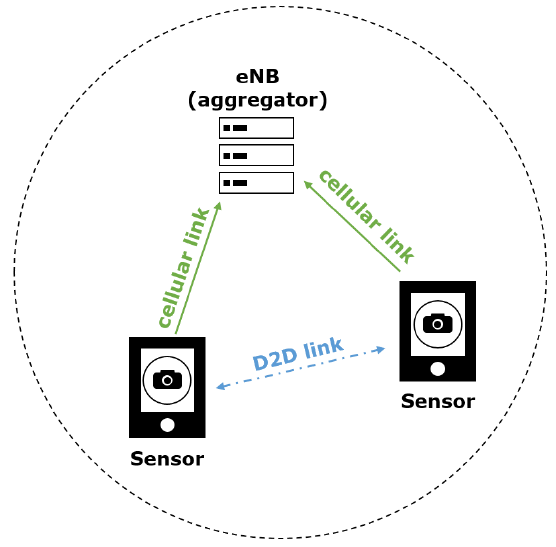
Figure 1. Cellular link and D2D link in